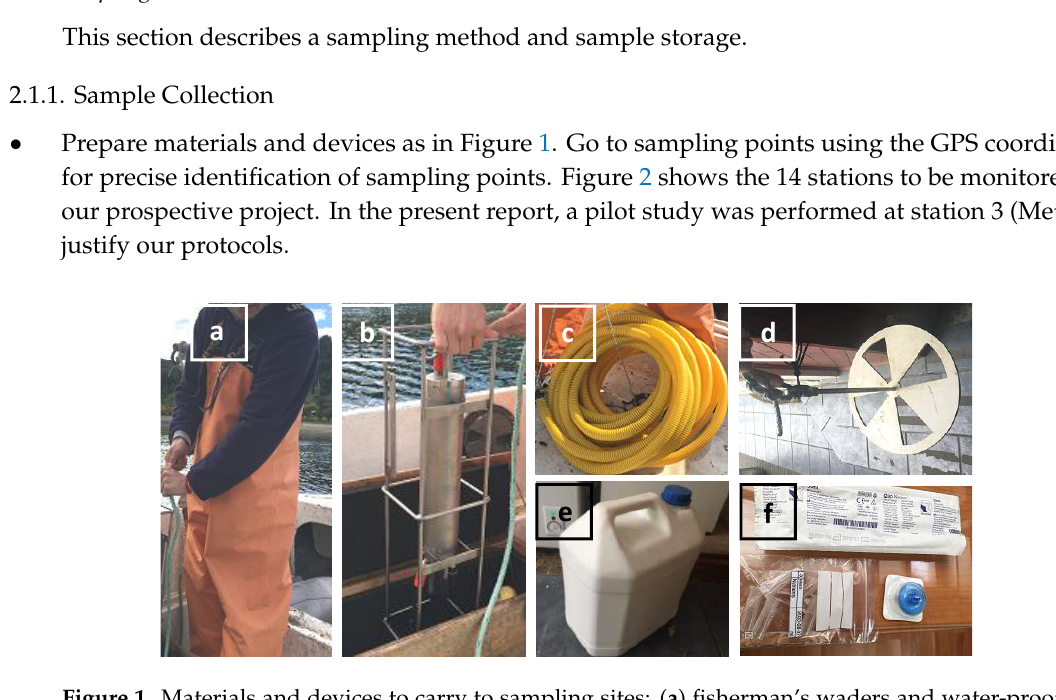
Figure 2. Sampling stations for prospective HAB monitoring program in Chile: at (1) Puerto Saavedra in Araucanía (−38.804; −73.516), (2) Paso Quenu in Calbuco (−41.807; −73.1672), (3) Metri in Puerto Montt (−41.597; −72.7056), (4) Club de Yates in Puerto Montt (−41.475; −72.934), (5) Bahía Mansa open ocean (−40.581; −73.737), (6) Cucao in Chiloé Island (−42.574; −74.259), (7) Isla San Pedro in Chiloé Island (−43.313; −73.662), (8) Isla Julia in Melinka (−43.901; −73.704), (9) Bahía Buena in Punta Arenas (−53.617; −70.914), (10) Puerto in Antofagasta (−23.652; −70.415), (11) Capilla in Antofagasta (−23.680; −70.423), (12) Puerto Costa in Antofagasta (−23.644; −70.399), (13) Capilla Costa in Antofagasta (−23.683; −70.420), (14) Bahía Mansa coast (−40.581; −73.737).